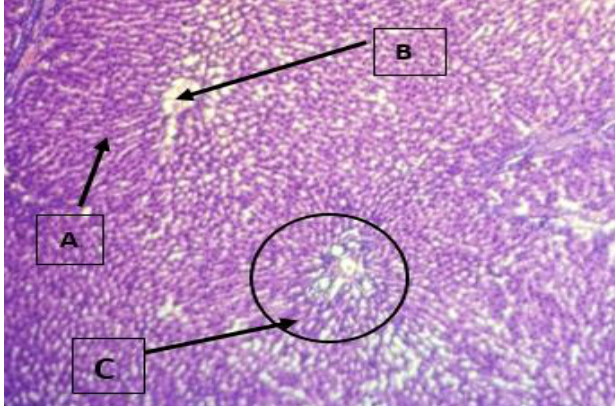
Fig 1. Photomicrograph Of rat liver control group showing radiating cords of hepatocytes (A), central vein (B), and portal triad (C) [control group 10X].